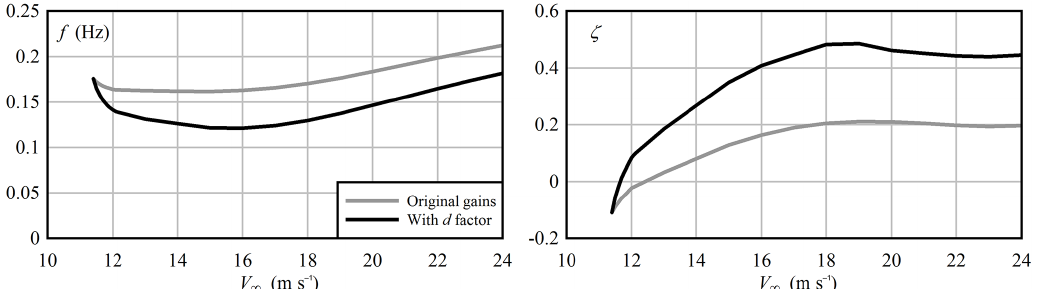
Figure 12. The natural frequency and damping ratio of the rotor speed control mode, where the integral gain has been properly scheduled inside the integrator, comparing the performance of the original published gains with the case where the gains are reduced by the d factor.